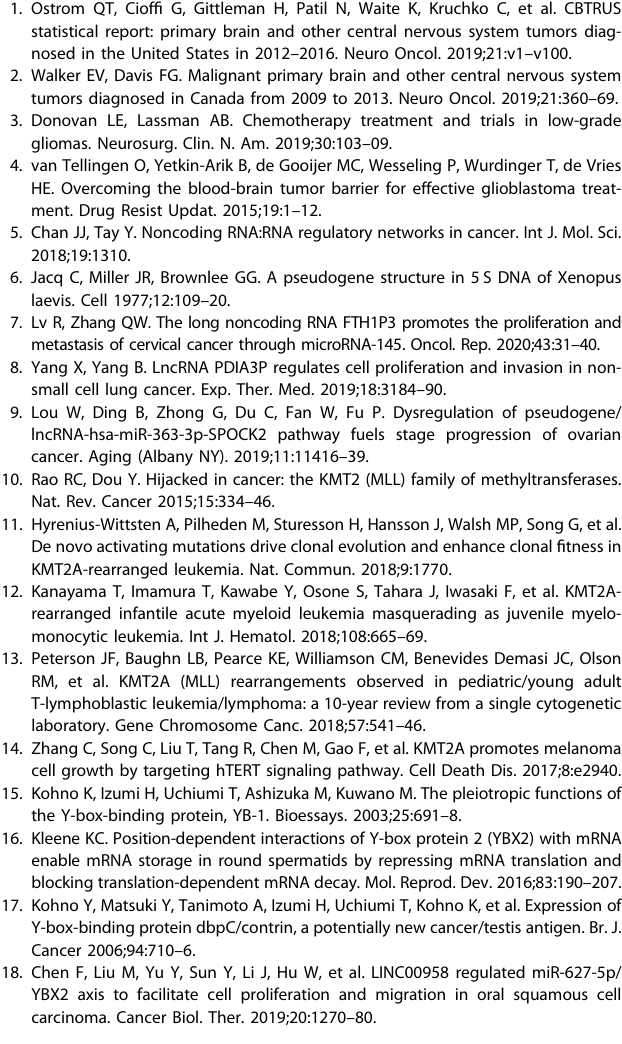
Western blot assay Western blot assay was performed as previously described [42]. For details, see Supplemental Materials and